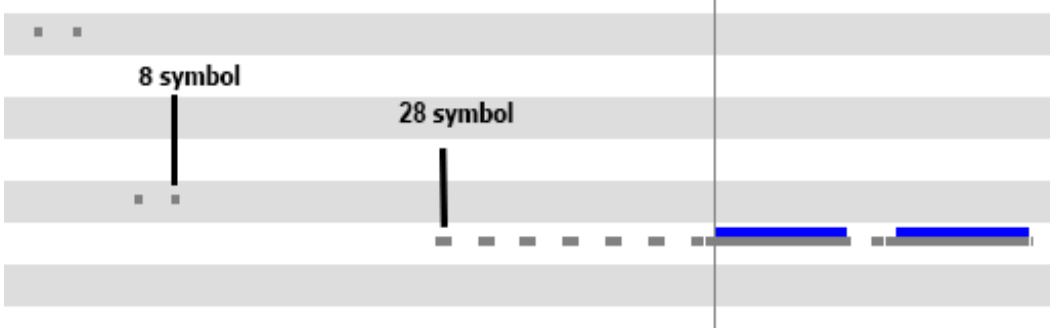
Figure 5. Model 1: RSSI check-in Rx (28 symbols) and Tx(28 symbols) in Cooja timeline.